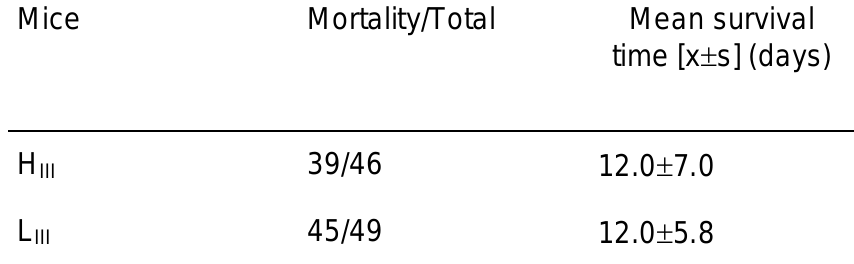
Table 1: Mortality of H infection.